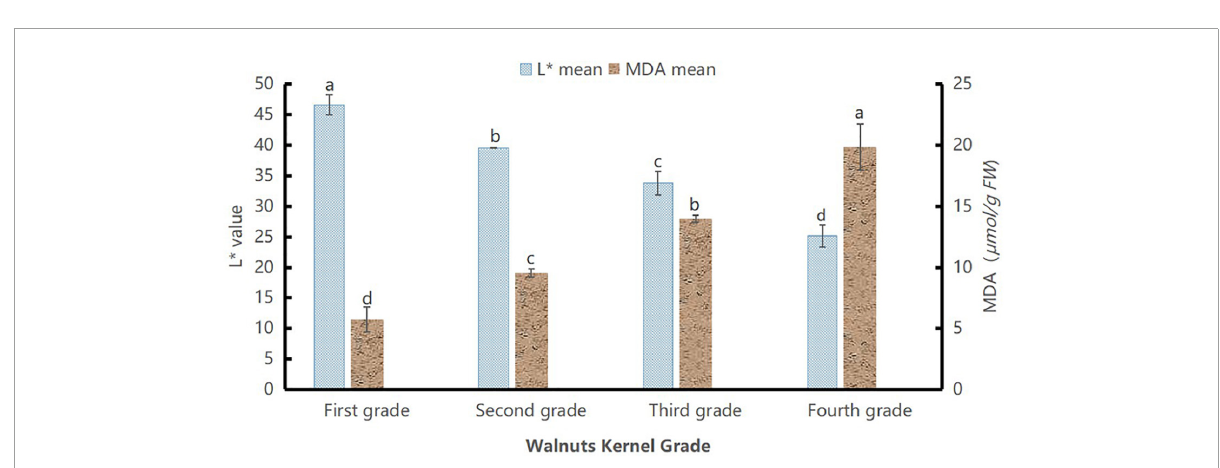
FIGURE4 L * values and malondialdehyde content of walnut samples of different grades. Different lowercase letters indicate significant differences between different grades of the same index ( P < 0.05).